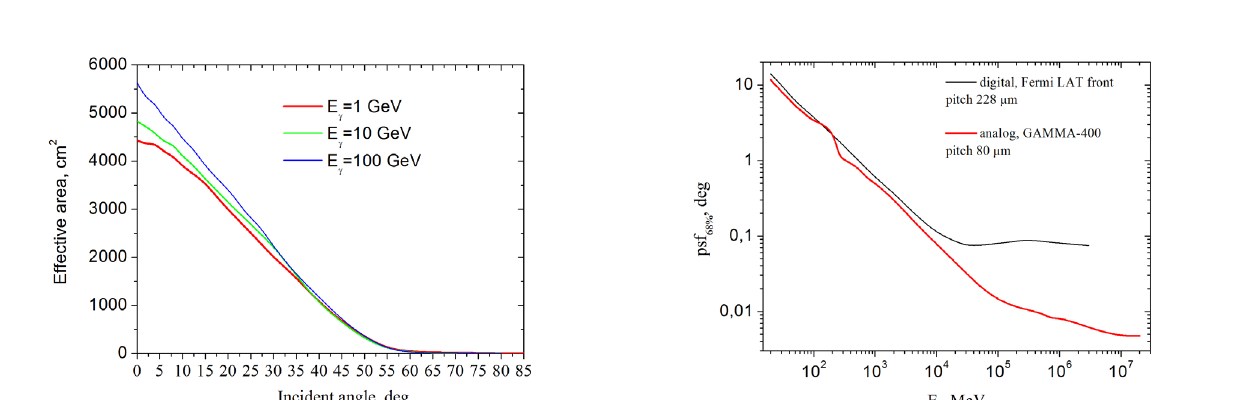
Figure 2. The interaction of the 100-GeV gamma ray with the GAMMA-400 matter with the formation of backscattering parti- cles. Secondary gammas, positrons and electrons are marked by Figure 4. The dependence of the e ff ective area vs the angle of yellow, violet and blue colors respectively incidence of particles for E γ = 1 GeV; E γ = 10 GeV; E γ = 100 GeV